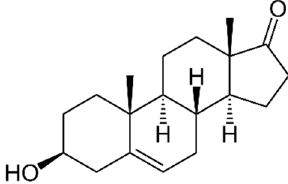
Figure 10. Chemical structure of DHEA. Formula: C 19 H 28 O 2 .